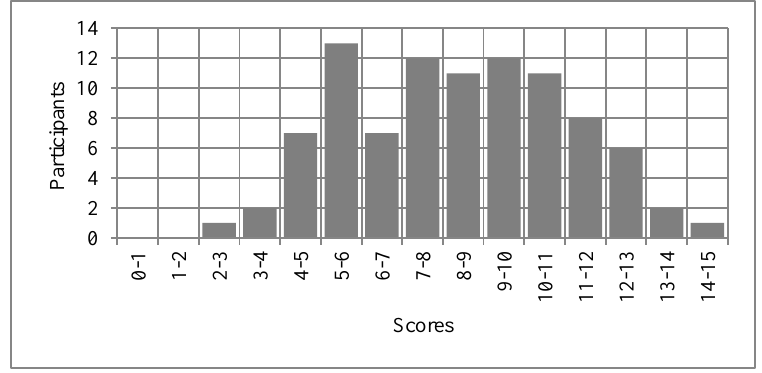
Fig. 5. Testing results on the topic "Conductors in a Magnetic Field" with the optimal ratio of the questions complexity and time for solving